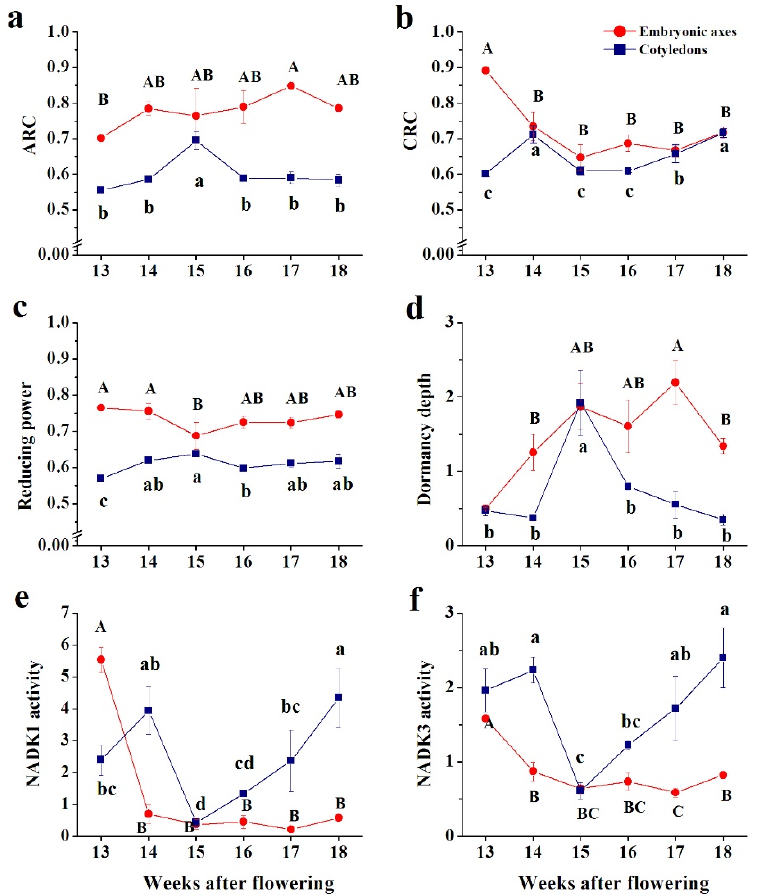
Figure 5. NAD(P)-originated physiological indices: ( a ) metabolism-related catabolic redox charge (CRC) and ( b ) anabolic redox charge (ARC); ( c ) reducing power; ( d ) dormancy depth; phosphorylation capacity of NADK1 ( e ); and NADK3 ( f ) calculated in embryonic axes and cotyledons of developing beech seeds at the 13–18th weeks after flowering (WAF) maturation range. Data represent the mean ± standard deviation of three independent replicates. Statistically significant differences are indicated with different letters (one-way ANOVA followed by Tukey’s test at p ≤ 0.05). The capital letters refer to embryonic axes.